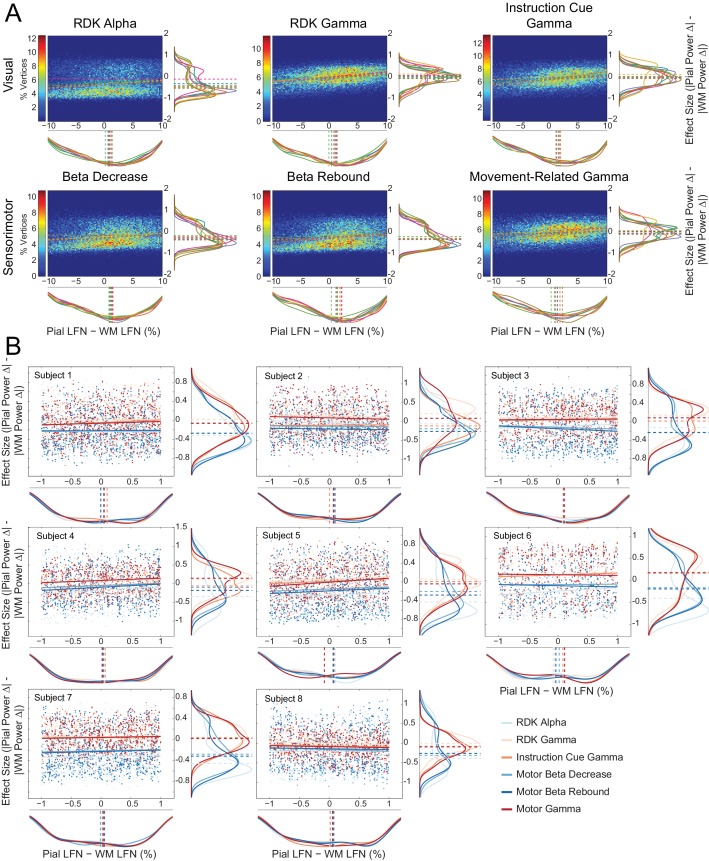
Laminar preference scales with the difference in pial and white matter lead field strength.(A) Each panel shows normalized bivariate histograms of the difference in lead field strength (lead field norm, LFN, constrained within ±10% of the mean pial/white matter lead field norm) between corresponding vertices on the pial and white matter surfaces, plotted against the effect size (Cohen’s d) of the laminar bias. The laminar bias is defined as the unsigned fractional change in power from baseline on the pial surface, minus the unsigned fractional change in power on the white matter surface. The color of each pixel represents the percentage of vertices in the ROI that fall within that bin. The histograms are normalized to show the mean percentage of vertices in each bin over all participants. The fitted relationship between the lead field strength difference and laminar bias for each participant is shown as a dashed line. Kernel density estimates of the marginal distributions are shown below and to the right of each histogram, with each participant plotted in a different color. The median value for each participant is plotted as a vertical dashed line. There is a positive correlation between the difference in lead field strength between pial and white matter vertex pairs and laminar preference, with localization favoring the vertex with the strongest lead field (visual alpha (RDK): ρ = 0.14, t(7)=4.28, p<0.005; visual gamma (RDK): ρ = 0.30, t(7)=10.23, p<0.001; visual gamma (instruction cue): ρ = 0.29, t(7)=6.43, p<0.001; sensorimotor beta decrease: ρ = 0.18, t(7)=4.33, p<0.005; sensorimotor beta rebound: ρ = 0.20, t(7)=5.89, p<0.001; sensorimotor gamma: ρ = 0.25, t(7)=4.72, p<0.005). (B) Each panel shows, for a single participant over all comparisons, scatter plots and fitted linear relationships of the difference in lead field strength (lead field norm, LFN) between corresponding vertices on the pial and white matter surfaces (as a percentage of the average pial/white matter LFN, restricted to ±1%) plotted against the effect size (Cohen’s d) of the unsigned fractional change in power from baseline on the pial surface, minus the unsigned fractional change in power on the white matter surface. Kernel density estimates of the marginal distributions are shown below and to the right of each histogram, with low frequency signals plotted in blue and high frequency signals in red. The median value for each comparison is plotted as a vertical dashed line. Even when the pial and white matter vertices have approximately the same lead field strength, there is a clear laminar separation between low and high frequency signals, with low frequency signals localizing to the white matter surface (visual alpha (RDK): W(8)=0, p=0.008; sensorimotor beta decrease: W(8)=0, p=0.008; sensorimotor beta rebound: W(8)=0, p=0.008) and high frequency signals unbiased toward either surface with the exception of RDK visual gamma which is biased toward the pial surface (visual gamma (RDK): W(8)=36, p=0.008; visual gamma (instruction cue): W(8)=16, p=0.844; sensorimotor gamma: W(8)=26, p=0.313).